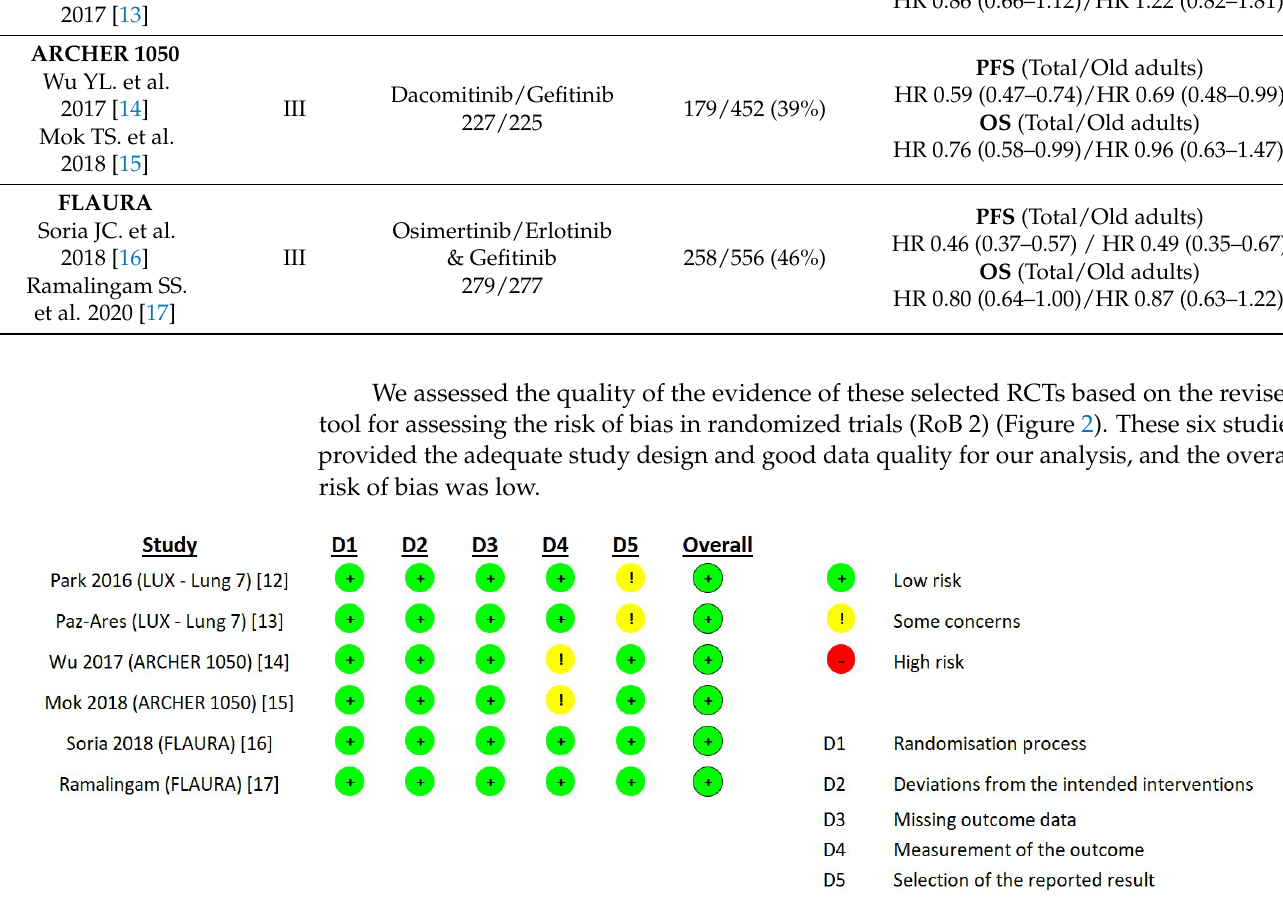
Figure 2. Risk of bias summary: review authors’ judgments about each risk of bias item for each included study.